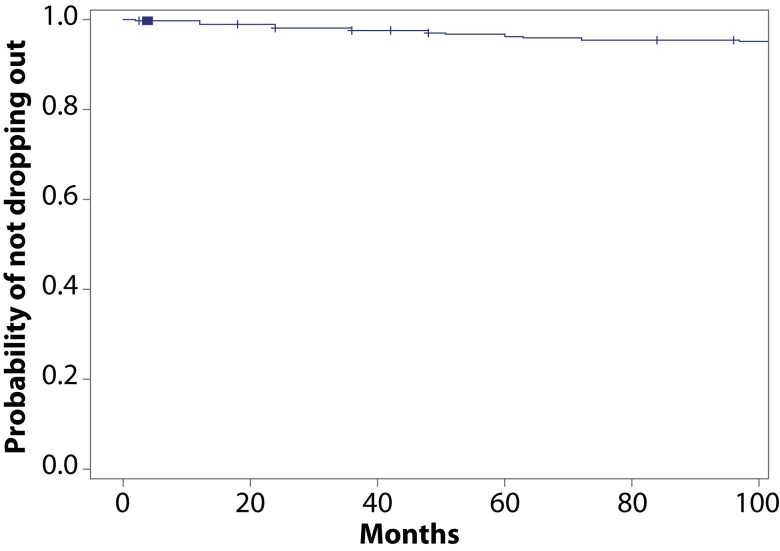
Study survival probability (by not dropping out of the study) including all subjects from pooled analyses (N = 75,764).